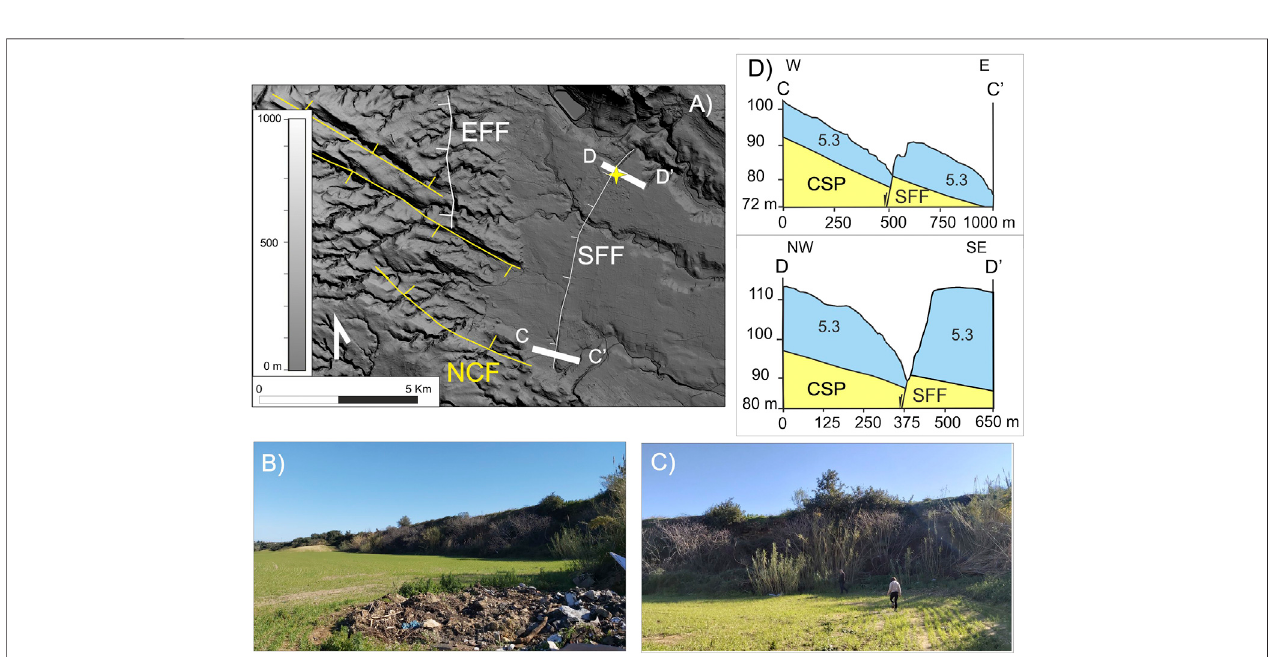
FIGURE9|(A) AdetailofDEMsouthofFloridiatownshowingthatSFFdisplacestheupperPleistoceneterrace(OIS5.3)andthefaultactivitycausedthede fl ection of the river course ( fi gure location in Figure 6B ). The yellow star indicates the location of (B,C) : photos of the 10 – 20 m high fault scarp along pro fi le D-D ’ . (D) pro fi les along SSF: C-C ’ shows the morphological scarp, the slope increase of the terrace (OIS 5.3) and the westwards shifting of the river valley; D-D ’ shows the fault morphological scarp and the asymmetry of the river valley with the rejuvenated pro fi le at footwall.